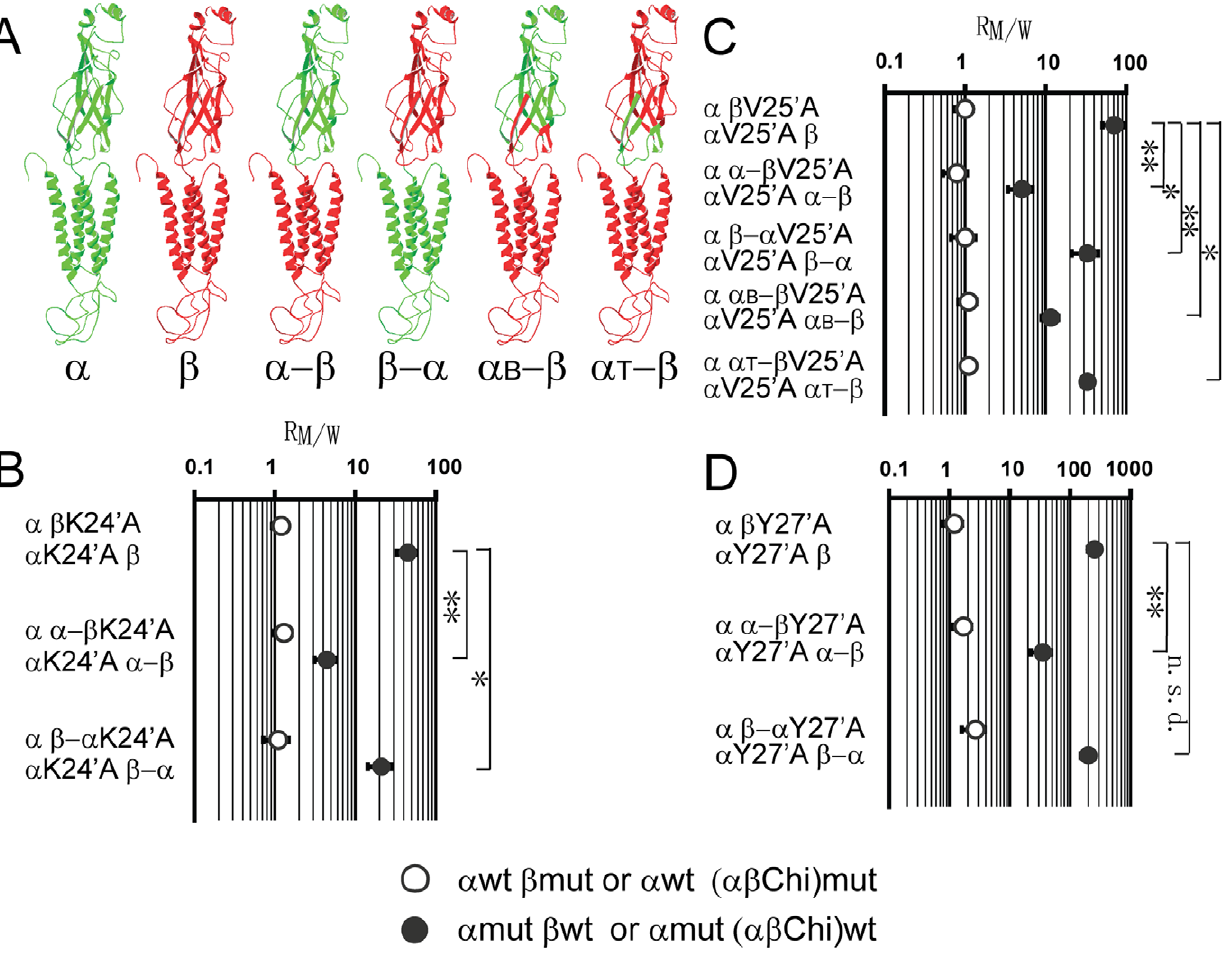
Figure 4. Effects of M2 – M3 loop mutations on chimeric a 1 b GlyR channel function. (A) The molecular identity of each chimera is schematically illustrated, with green and red denoting a 1 and b subunit sequences, respectively. (B–D) The R M/W s (the EC 50 of the mutant chimeric a 1 b GlyR divided by the EC 50 of its relevant WT chimeric a 1 b GlyR) resulting from introducing the K24 9 A, V25 9 A or Y27 9 A mutation. The symbol ( # ) represents constructs containing WT a 1 and mutant b or other indicated chimeric subunit, while the symbol ( mutant a 1 and WT b or other indicated chimeric subunit. ( * p , 0.05; ** p , 0.01; n.s.d. not significantly different; using the Student’s t-test). doi:10.1371/journal.pone.0028105.g004 PLoS ONE |